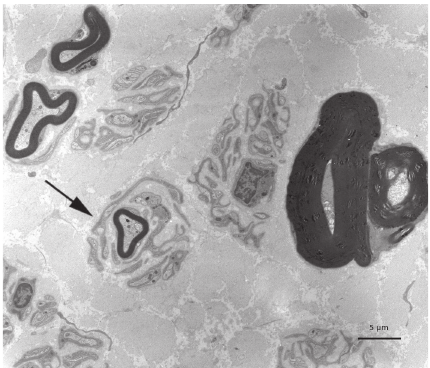
Figure 4: A myelinated axon is surrounded by onion bulb forma- tions in a patient with the CIDP-like profile. Electron micrograph, transverse